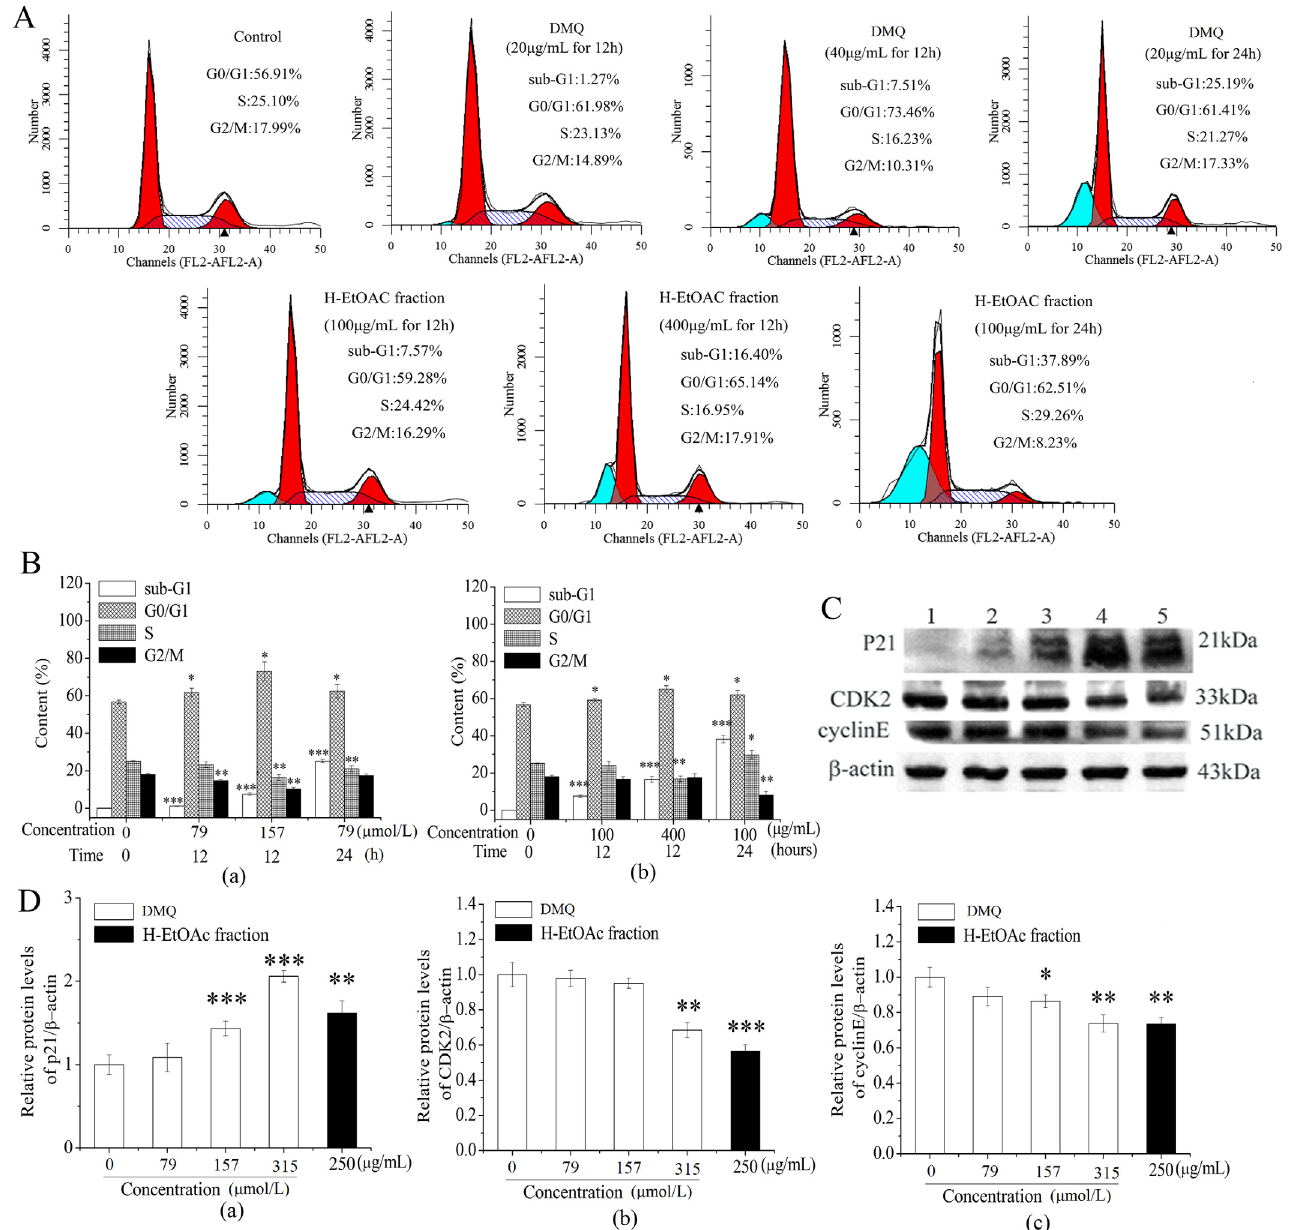
Fig 7. Cell Cycle Arrest of HepG2 Cells Treated with DMQ and H-EtOAc Fraction. A. The cell cycle distribution of treated HepG2 cells. B. Contents of each phase of HepG2 cells treated with DMQ (a), H-EtOAc fraction (b). C. Western blot analysis of p21, CDK 2 and cyclin E. Lane 1: Control; Lane 2 – 4: 79, 157 and 315 μ mol/L of DMQ for 24 h, respectively; Lane 5: 250 μ g/mL of H-EtOAc fraction for 24 h. D. The protein expression levels of p21 (a), CDK 2 (b) and cyclin E (c). The protein expression strength were analyzed by scanning densitometry using a Microtek ScanMaker 8700 (Zhongjing Inc. China) with ScanWizard 5 software. Values are means ± SD of three independent experiments. * ( p < 0.05), ** ( p < 0.01) and *** ( p < 0.001) represented significant differences compared to the